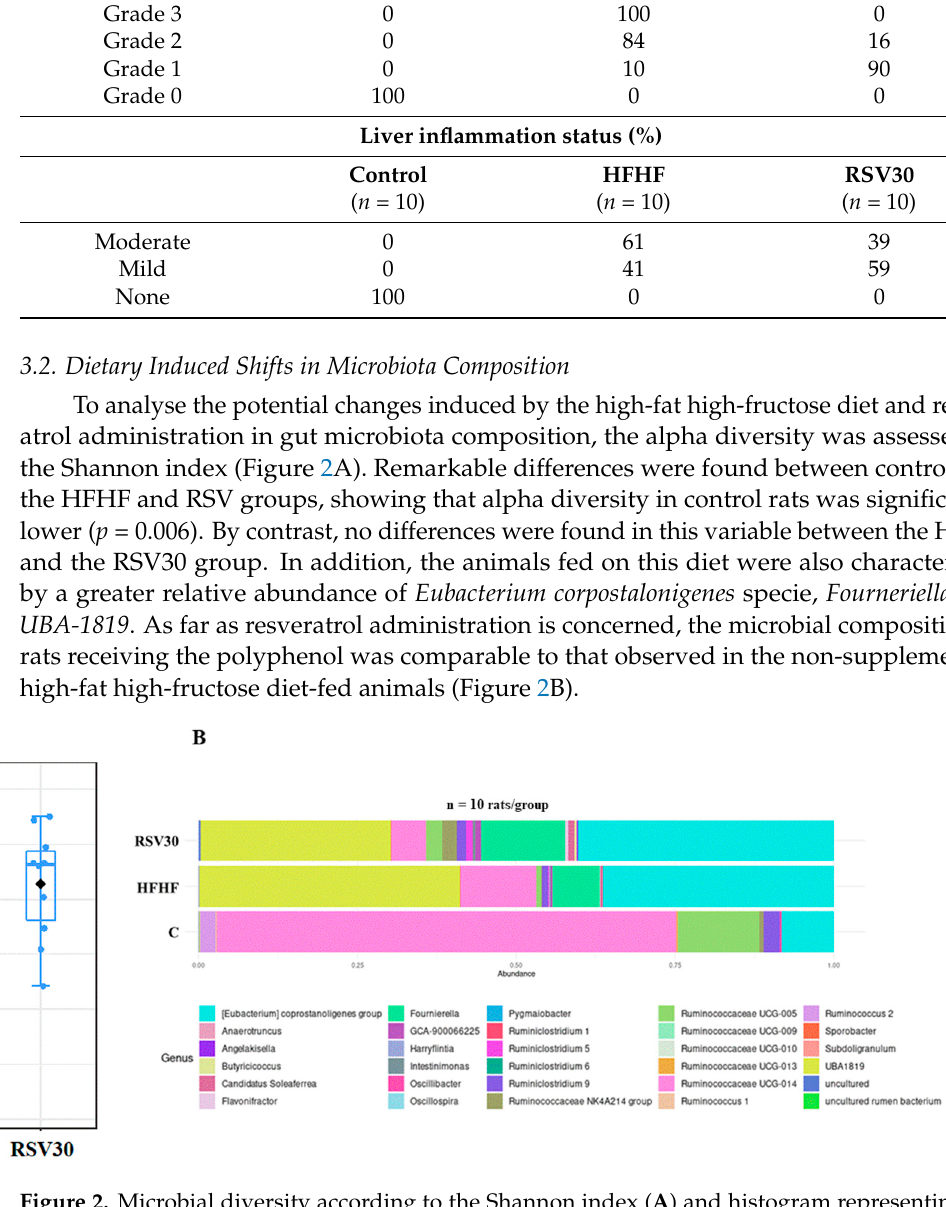
Figure 2. Microbial diversity according to the Shannon index ( A ) and histogram representing the relative abundances of bacteria within the Ruminococcaceae family ( B ) measured in faecal samples in rats fed a control diet ( C ), a high-fat high-fructose diet (HFHF) or a high-fat-high-fructose diet supplemented with 30 mg/kg/d resveratrol (RSV30).